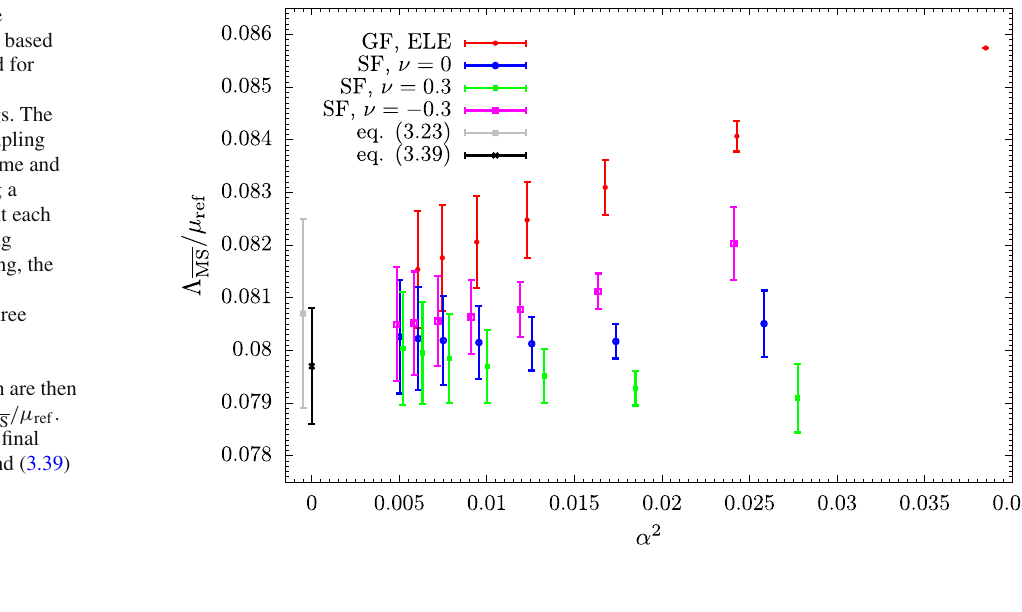
Fig. 14 Results for the /μ extraction of (cid:3) ref based MS on several schemes, and for different values of the corresponding couplings. The results from the GF coupling refer to its electric scheme and are computed following a step-scaling analysis. At each value of the GF coupling coming from step-scaling, the GF scheme is matched non-perturbatively to three different SF schemes corresponding to ν = − 0 . 3 , 0 , 0 . 3, which are then /μ used to also extract (cid:3) ref . MS A comparison with our final estimates Eqs. (3.23) and (3.39) is